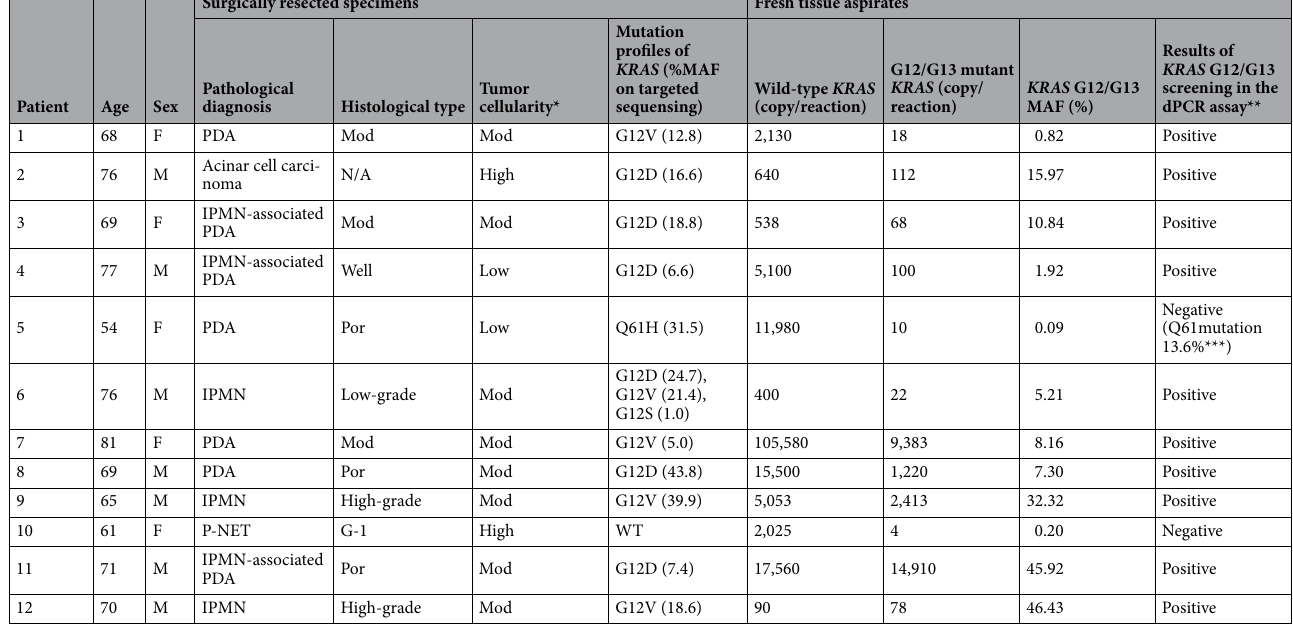
Table 1. KRAS mutation analysis in punctured specimens obtained from resected pancreatic tumor tissues. IPMN intraductal papillary mucinous neoplasm, MAF mutant allele frequency, PDA pancreatic